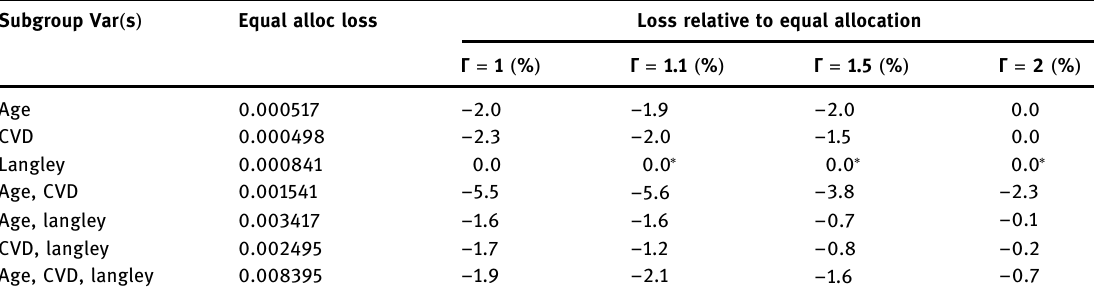
Table 1: L 2 loss comparisons for regret - minimizing allocations relative to equal allocation Subgroup Var ( s )